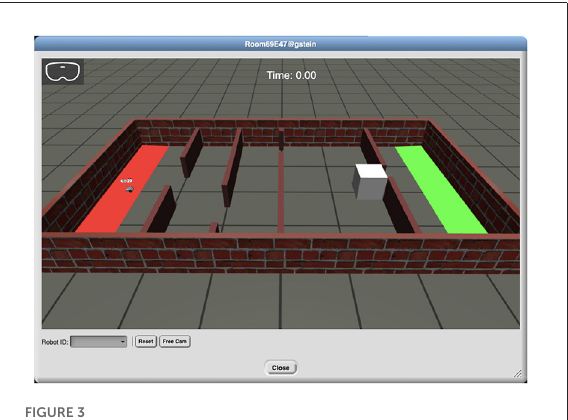
FIGURE3 RoboScape Online 3D view showing “obstacle course” environment. The robot is in its starting position in the red